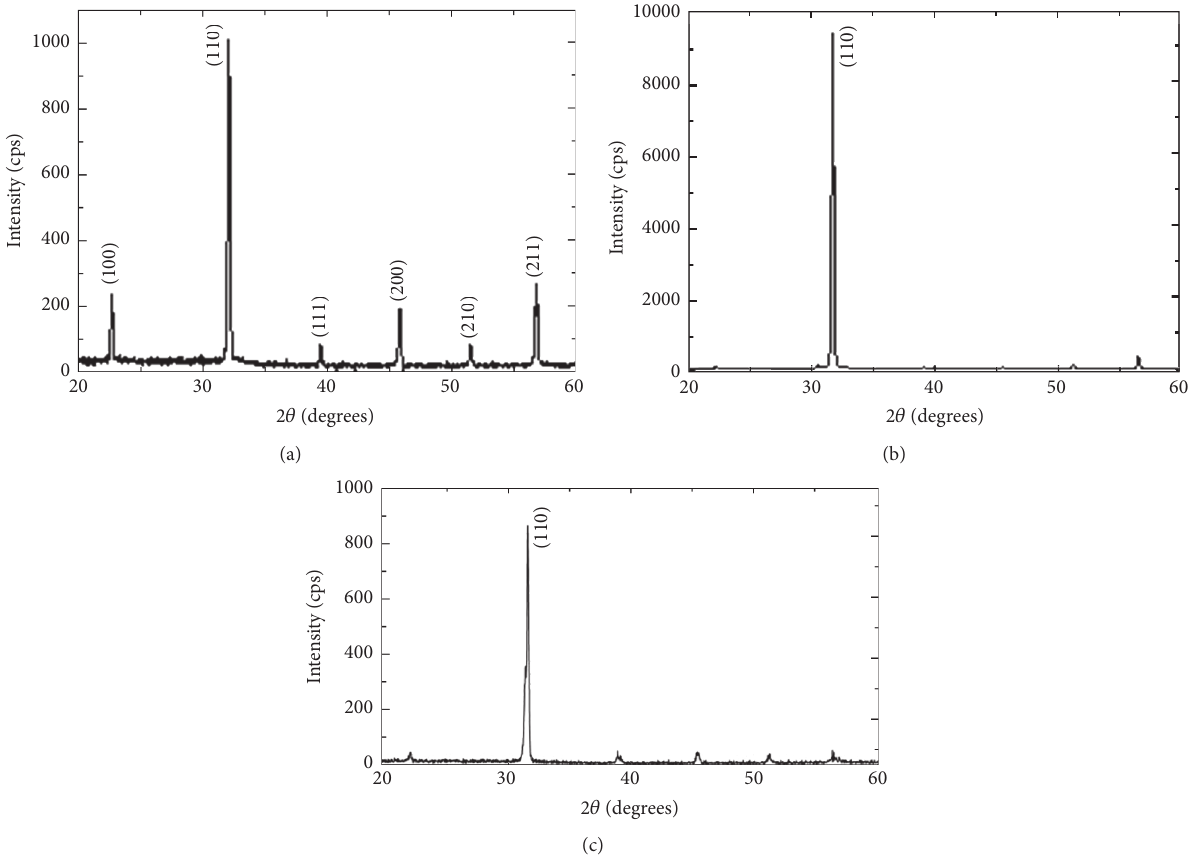
Figure 3: X-ray diffraction of TlBr powder (a) and TlBr crystal